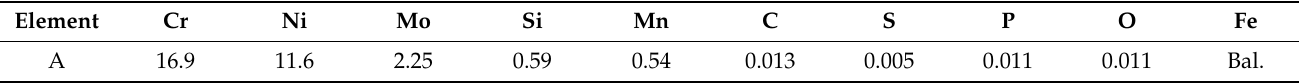
Table 2. Chemical compositions of the as-received 316L powder (wt.%).